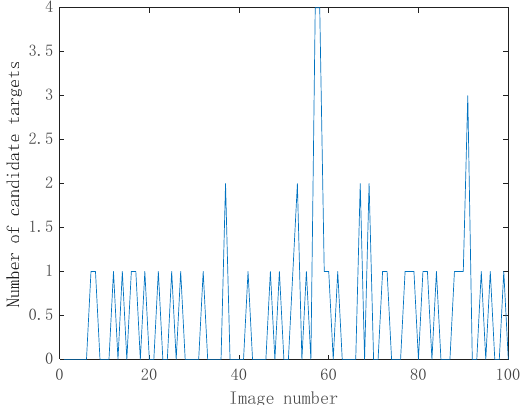
Figure 7. Number of point source image candidates retained in the 100 image patches.